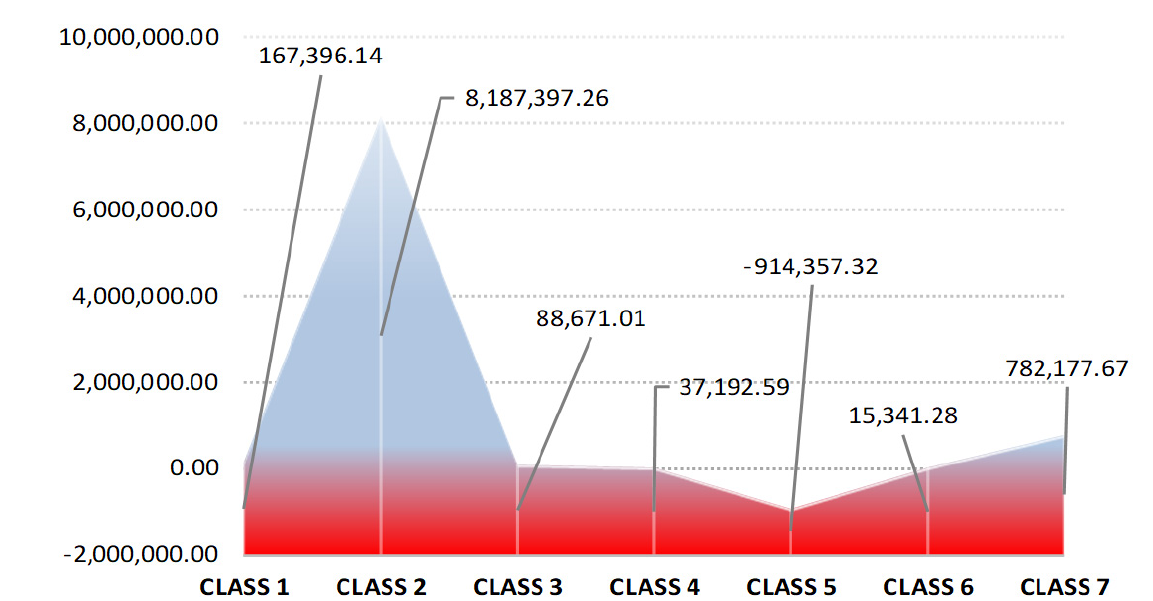
Figure 4. Evolution of average indebtedness at industry level ( € ). Source: Authors’ processing based on the information provided on Topfirme.com. Accessed date: 5 June 2018.